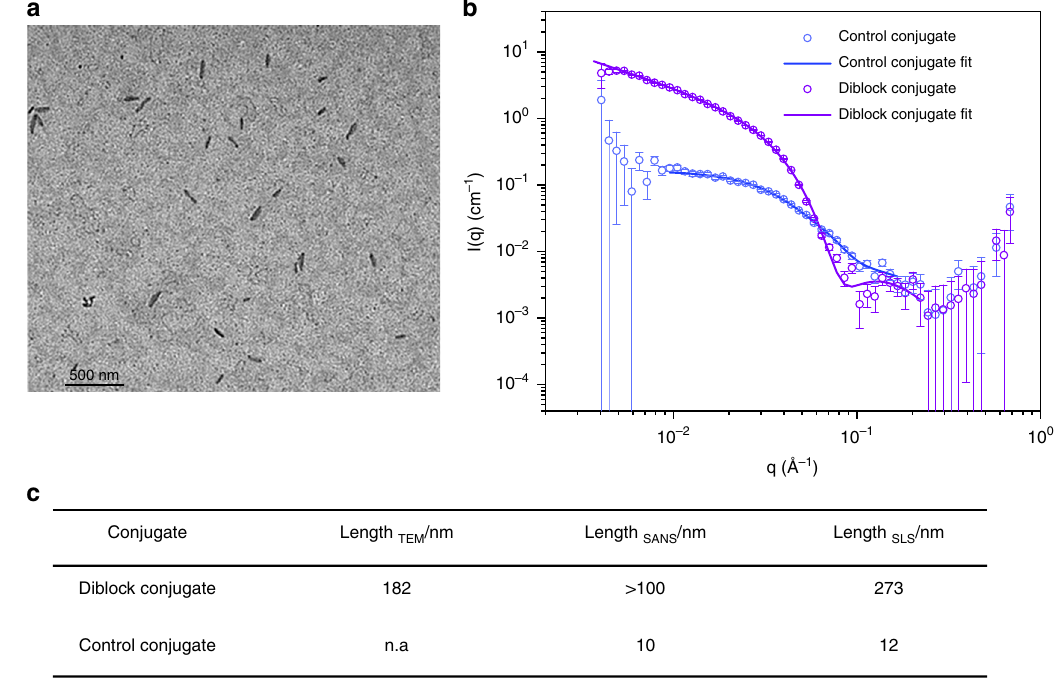
Fig. 2 Characterisation of cyclic peptide-polymer nanotubes. a Transmission electron microscopy (TEM) of the diblock conjugates prepared in water. b Small- Angle Neutron Scattering (SANS) of the diblock ( 12 ) and control ( 13 ) conjugates fi tted to a cylindrical micelle model using SAS fi t software. The error bars plotted are standard error of the mean. c Table of the average length of the nanotubes measured via TEM, SANS and static light scattering (SLS), respectively